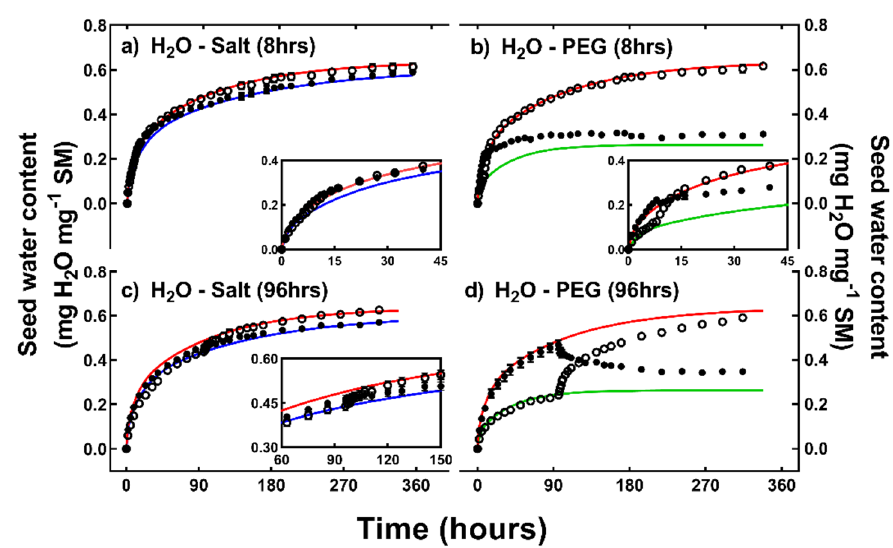
Figure 5. Seed water content curves for seeds transferred between water and salt ( a , c ) or water and PEG ( b , d ) solutions after 8 ( a , b ) or 96 ( c , d ) h. Red, blue, and green lines represent the time course for water, salt, and PEG controls respectively. Filled symbols represent seeds transferred from water to NaCl or PEG solutions, while open symbols represent seeds transferred from NaCl or PEG to water. Insets show details of water contents immediately around the time of transfer.